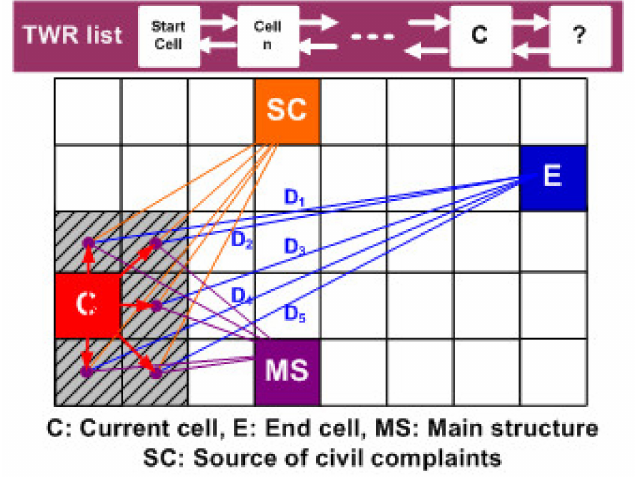
Figure 5. Elements of a cost model and TWR